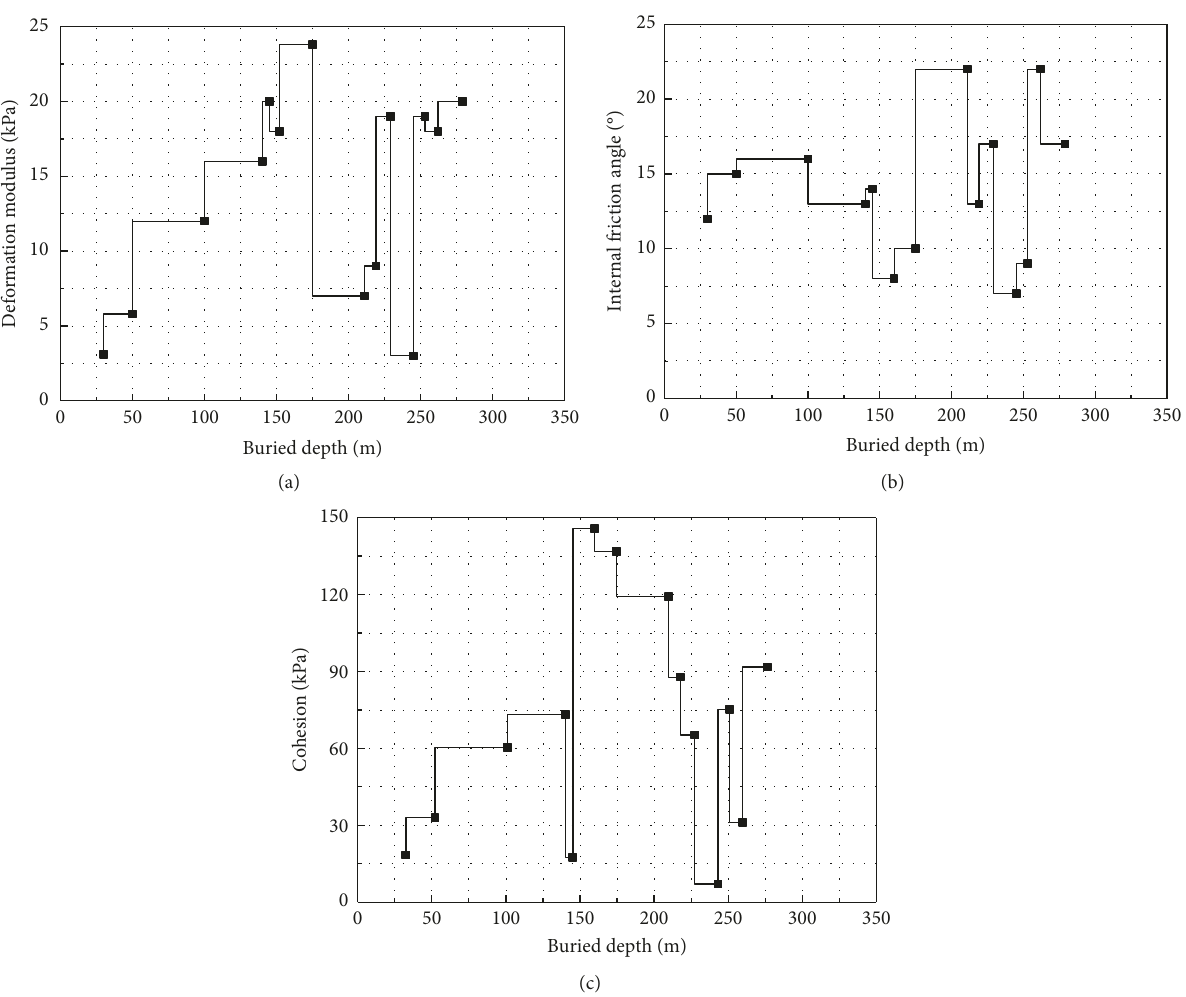
Figure 1: Variation of rock-soil parameters with buried depth. (a) Elastic modulus; (b) friction angle; (c)